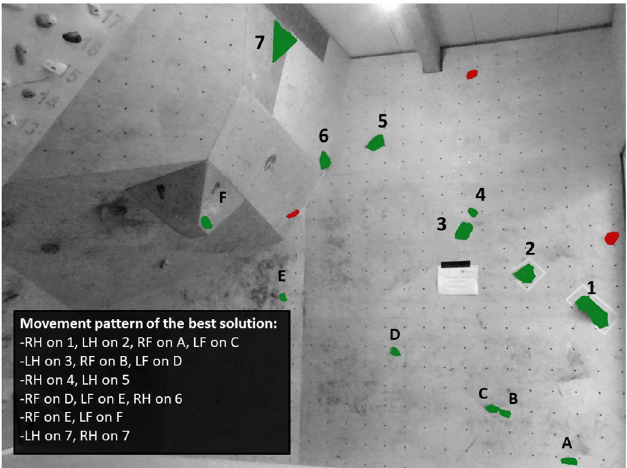
Fig 3. The bouldering task in Experiment 2 (RH: Right hand; LH: Left hand; RF: Right foot; LF: Left foot). In contrast to Experiment 1, the handhold number seven was removed and the handhold number four was replaced by a smaller handhold, which was set closer to the handhold number three. Experts also set a total of three error grips (i.e., marked in red colour), which were impossible to grasp and did not contribute to the completion of the task. The experts’ best solution is displayed in the movement